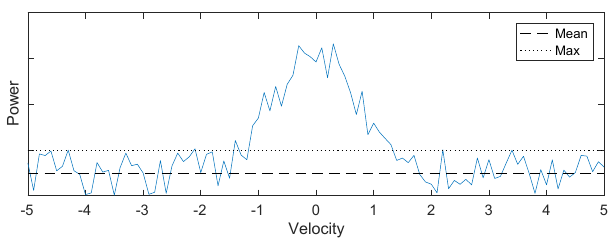
Figure 2. Theoretical Gaussian Doppler spectrum with added ran- dom noise, with the mean (dashed line) and maximum (dotted line) noise levels.